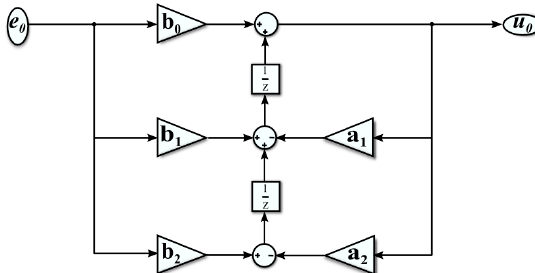
Figure 7. Discrete-time PIDF controller model: biquad cascade IIR filters using a direct form II transposed structure.